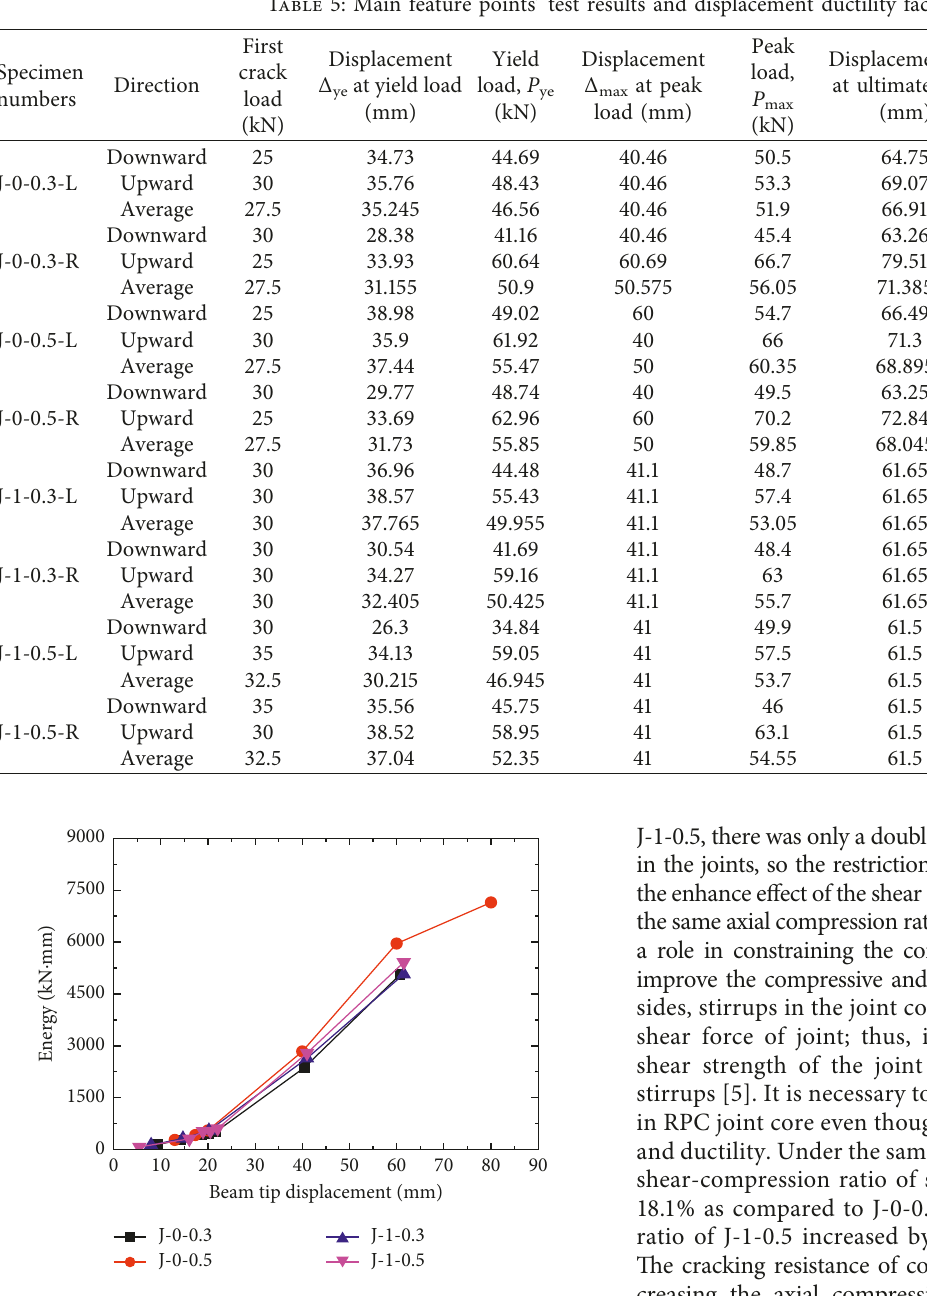
Figure 11: Energy dissipation of joint